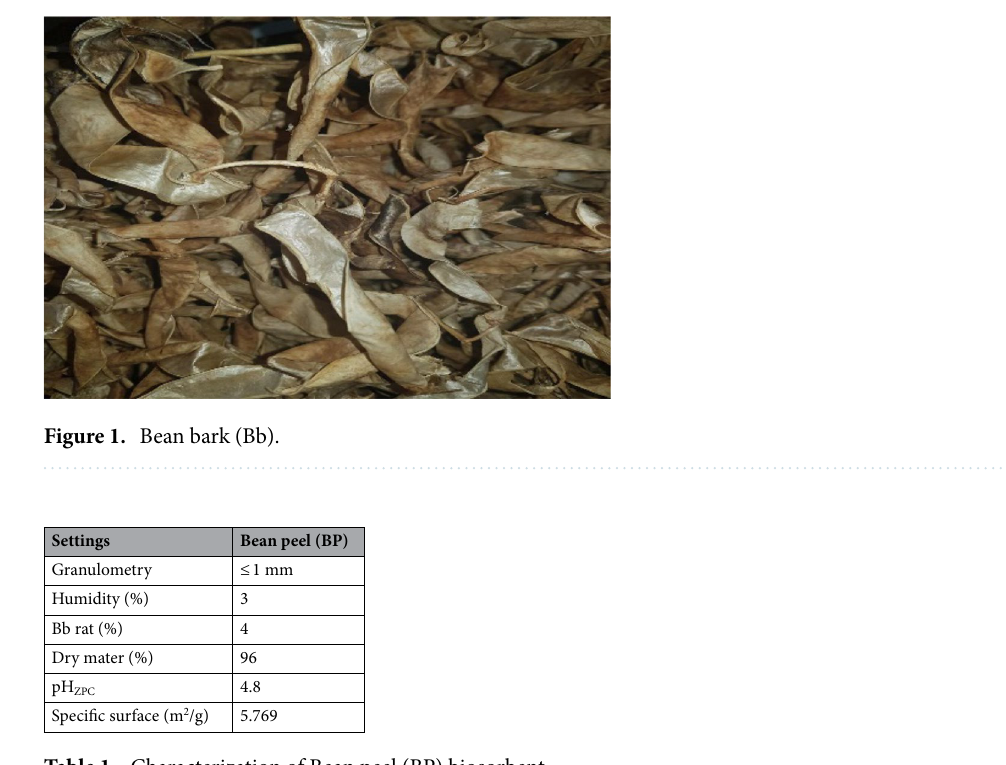
Table 1. Characterization of Bean peel (BP) biosorbent.